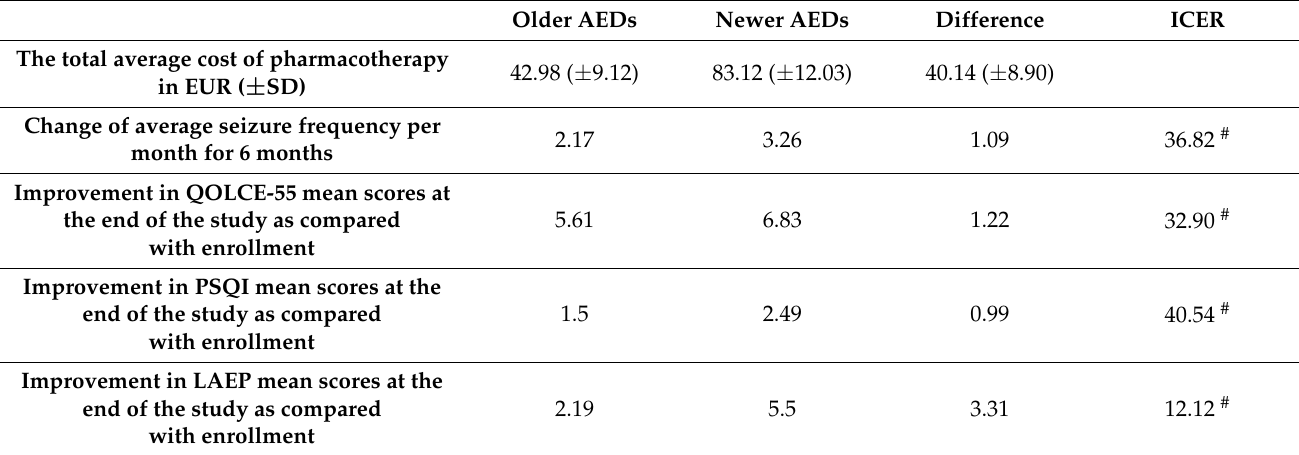
Table 3. Incremental cost-effectiveness ratio value between the patients on older and newer